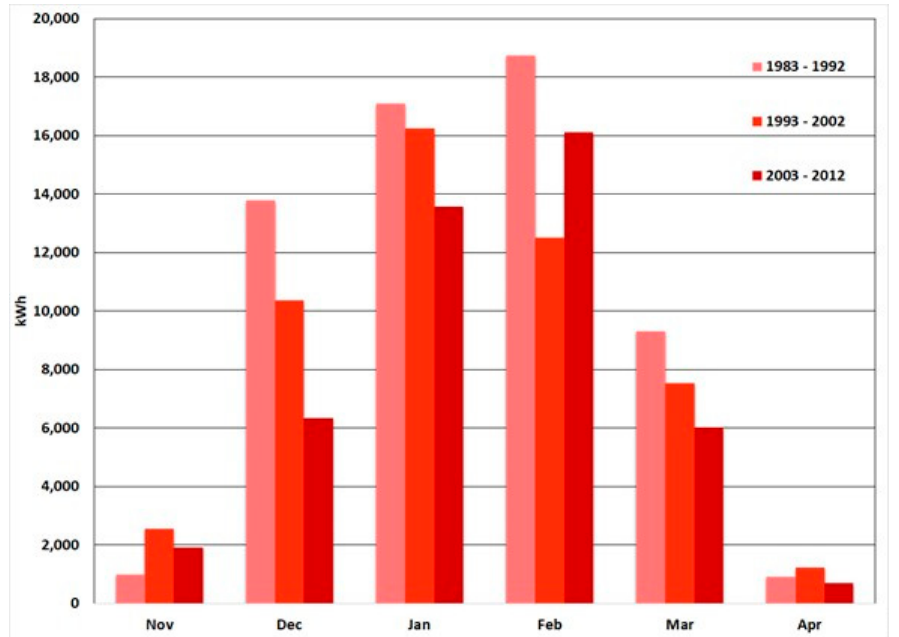
Figure 11. Total (sensible and latent) monthly energy requirements for heating.